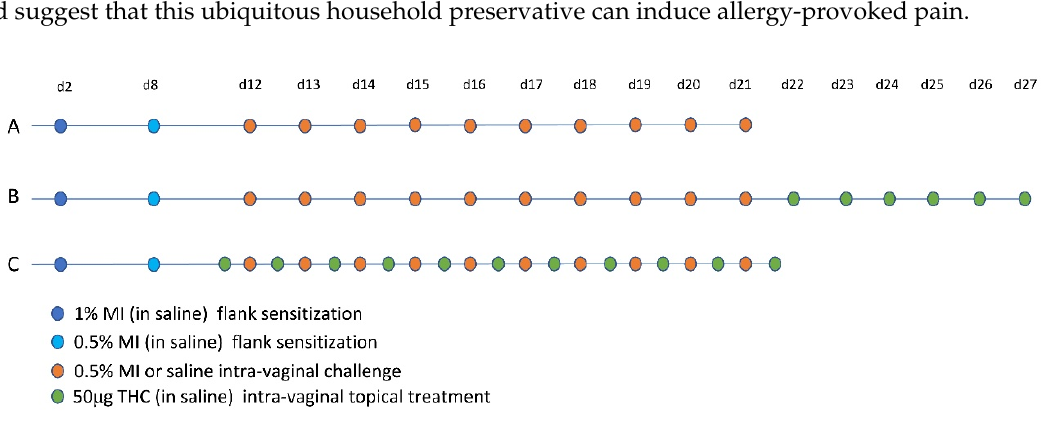
Figure 2. Sensitization, challenge, and treatment timelines. Schedule of MI in saline flank sensitizations and challenges ( A–C ). ( B ) Therapeutic intra-vaginal ∆ -9-tetrahydrocannabinol (THC) treatment timeline. ( C ) Preventative intra-vaginal THC treatments.